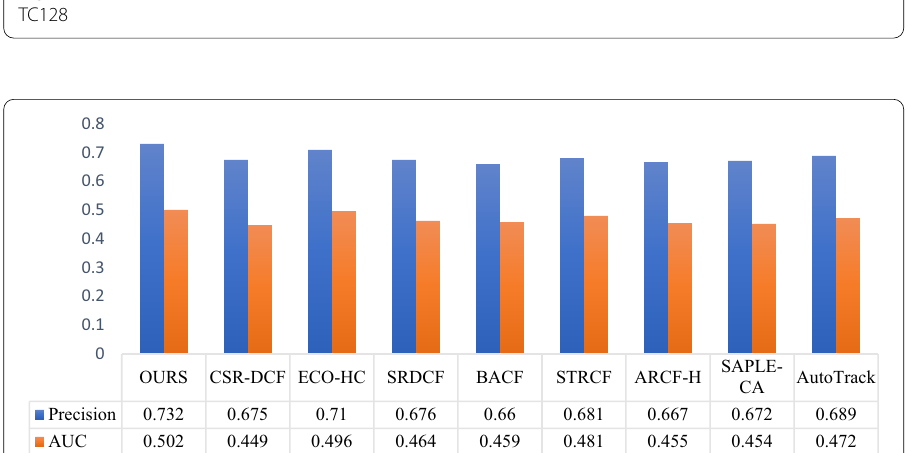
Fig. 10 Comparison of our tracker and other 8 excellent trackers in terms of precision and success rate